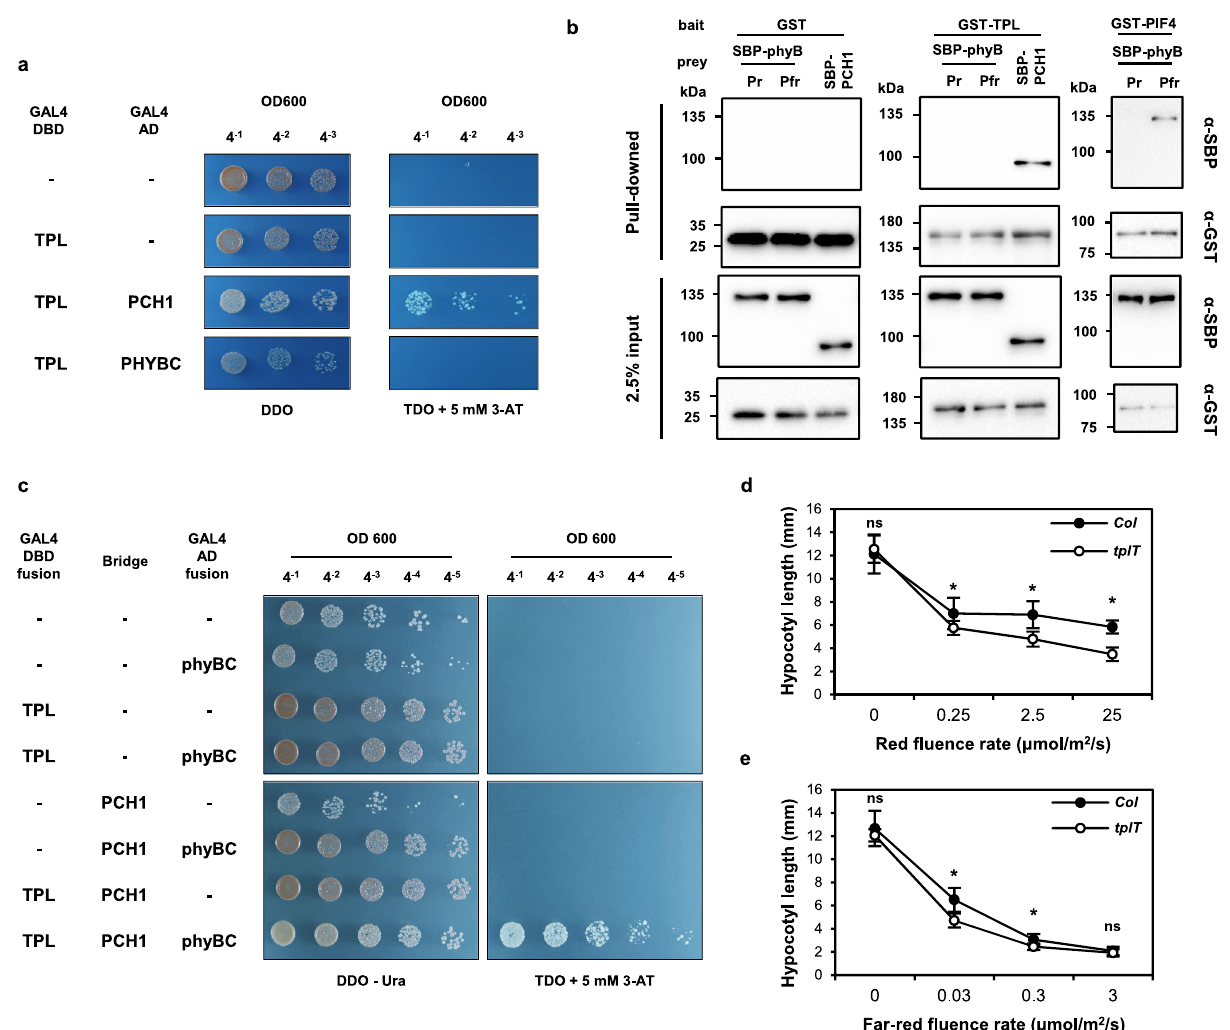
Fig. 6 | TPL/TPR family members are PCH1-interacting phyB photobody com- ponents that regulate hypocotyl elongation. a Yeast two hybrid assay showing the interaction between TPL and PCH1 but not between TPL and the C-terminal domain of phyB (phyBC) in a yeast two-hybrid assay. The assay was performed with TPL fused to the GAL4 DNA binding domain (GAL4 DBD) and PCH1 and phyBC fused to the GAL4 transactivation domain (GAL4 AD). DDO: double drop- out synthetic medium lacking leucine and tryptophan. TDO: triple drop-out synthetic media lacking histidine, leucine, and tryptophan. 3-AT: 3-amino-1,2,4- triazole. Yeast transformants selected on DDO were serially diluted (OD600) and spotted on DDO and TDO with 5mM 3-AT. Empty vectors are marked as “ - ” . b In vitro pull-down assay showing the interaction between TPL and PCH1 but not between TPL and phyB. GST and GST-fused TOPLESS (GST-TPL) or PIF4 (GST- PIF4) were incubated with SBP-fused PCH1 (SBP-PCH1) or phyB (SBP-phyB) and pulled down with glutathione resin. Both input (2.5% input) and pulled down (pull-down) proteins were detected with either anti-GST antibody ( α -GST) or